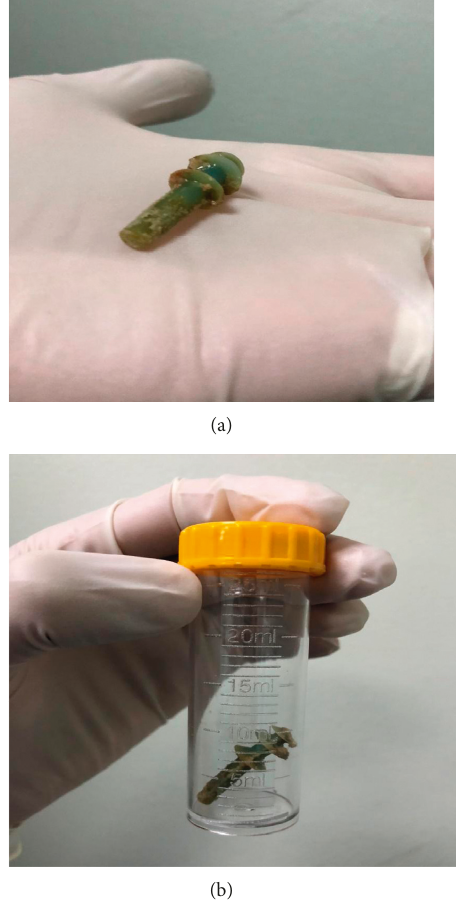
Figure 2: Foreign body after